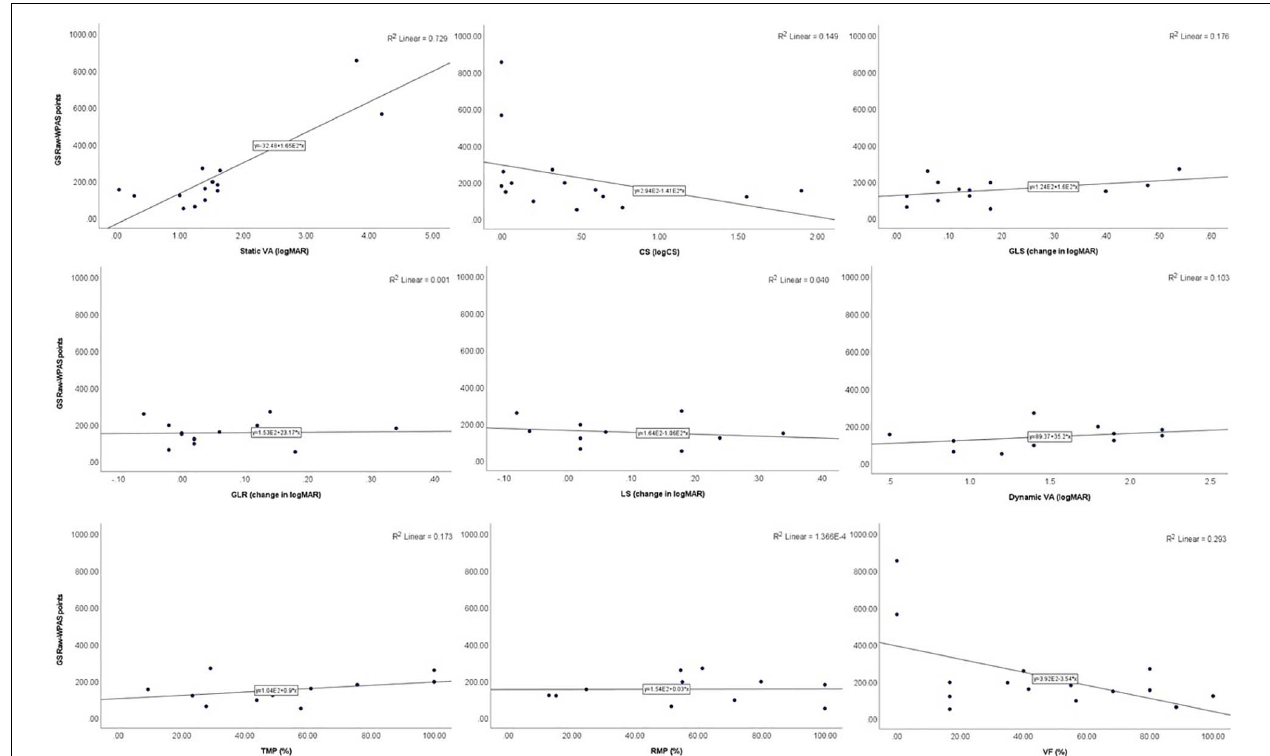
FIGURE 4 | Scatter plots showing the relationships between GS raw-WPAS points and visual